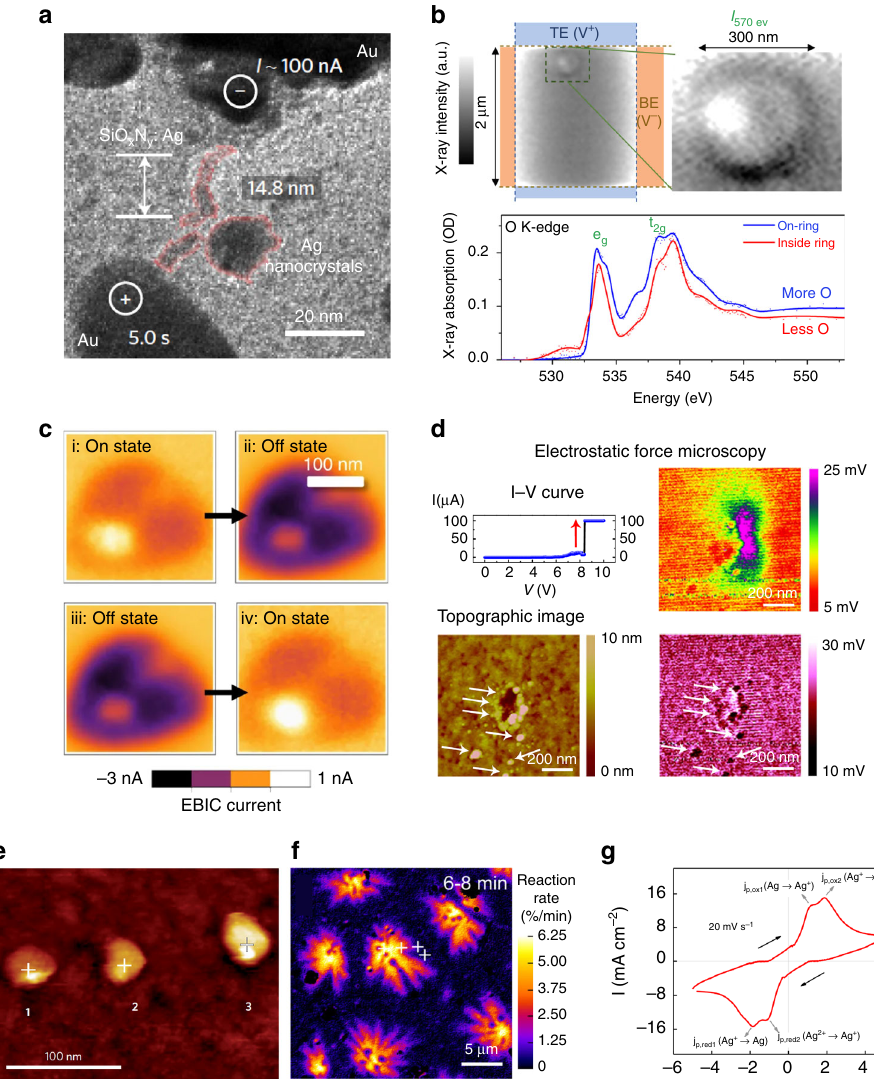
Fig. 4 Representative experimental results obtained by in situ techniques. a in situ TEM: observation of conduction fi laments in diffusive memristors, Au/ SiO x N y :Ag/Au device. b in situ STXM: the oxygen concentration difference in a ring-like feature during the resistive switching of HfO x memristors. c in situ EBIC: switching micrographs between on and off state in TiO 2 memristor. d in situ CAFM: topography and electrical measurement of the accumulation of oxygen ions in HfO 2 memristors. e in situ STM: highly conductive region in TaO x fi lm. f in situ optical microscopy: the redox reaction dynamics in graphene. g in situ cyclic voltammetry: redox reaction peak of Ag in Pt/graphene oxide/Ag memristors. Reproduced from ref. 9 , Macmillan Publishers Ltd ( a ); ref. 51 , American Chemical Society ( b ); ref. 52 , Nature Publishing Group ( c ); and ref. 53 , Nature Publishing Group ( d ); ref. 30 , Macmillan Publishers Ltd ( e ); ref. 56 , American Chemical Society ( f ); ref. 57 , WILEY-VCH Verlag GmbH & Co. KGaA, Weinheim ( g